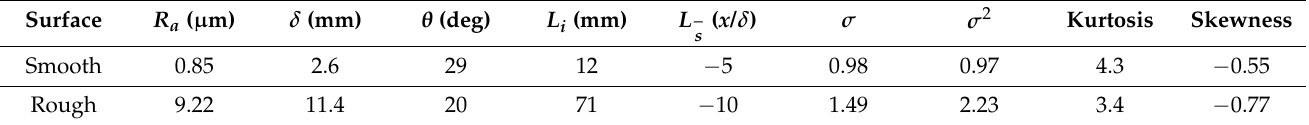
Table 3. Summary of shock-motion using descriptive statistics.